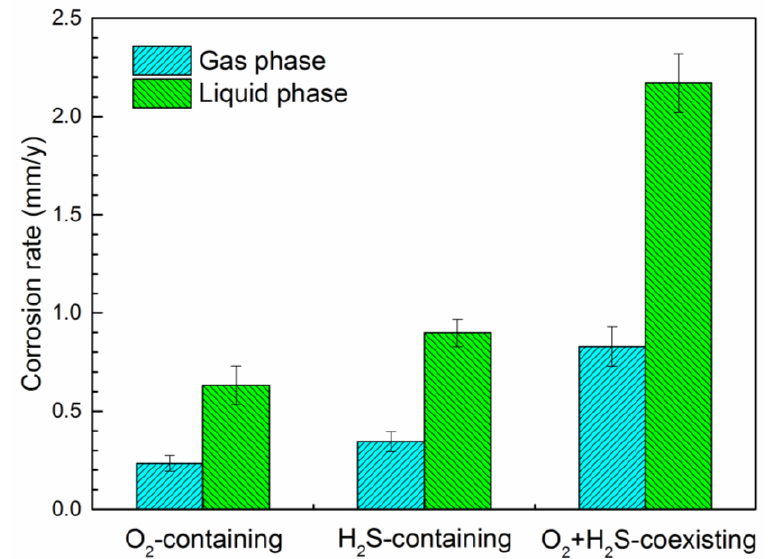
Figure 3. Corrosion rates of G20 steel in different conditions.